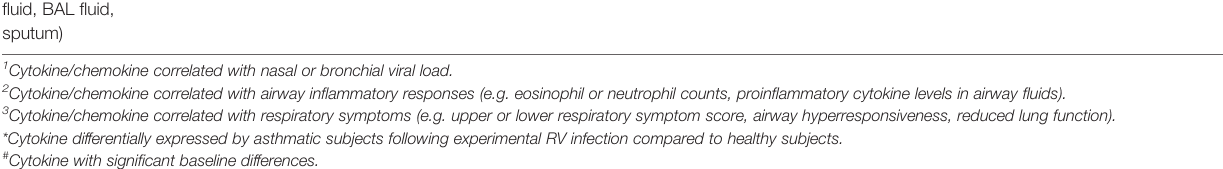
TABLE 3 | Findings of human experimental studies comparing nasal and bronchial cytokine responses in asthmatic vs healthy individuals. Upper and lower airway cytokine